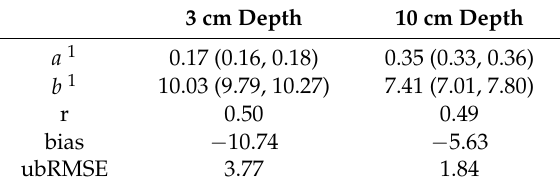
residual (LAR) method. Confidence intervals (95%) are presented in parentheses. Bias and unbiased